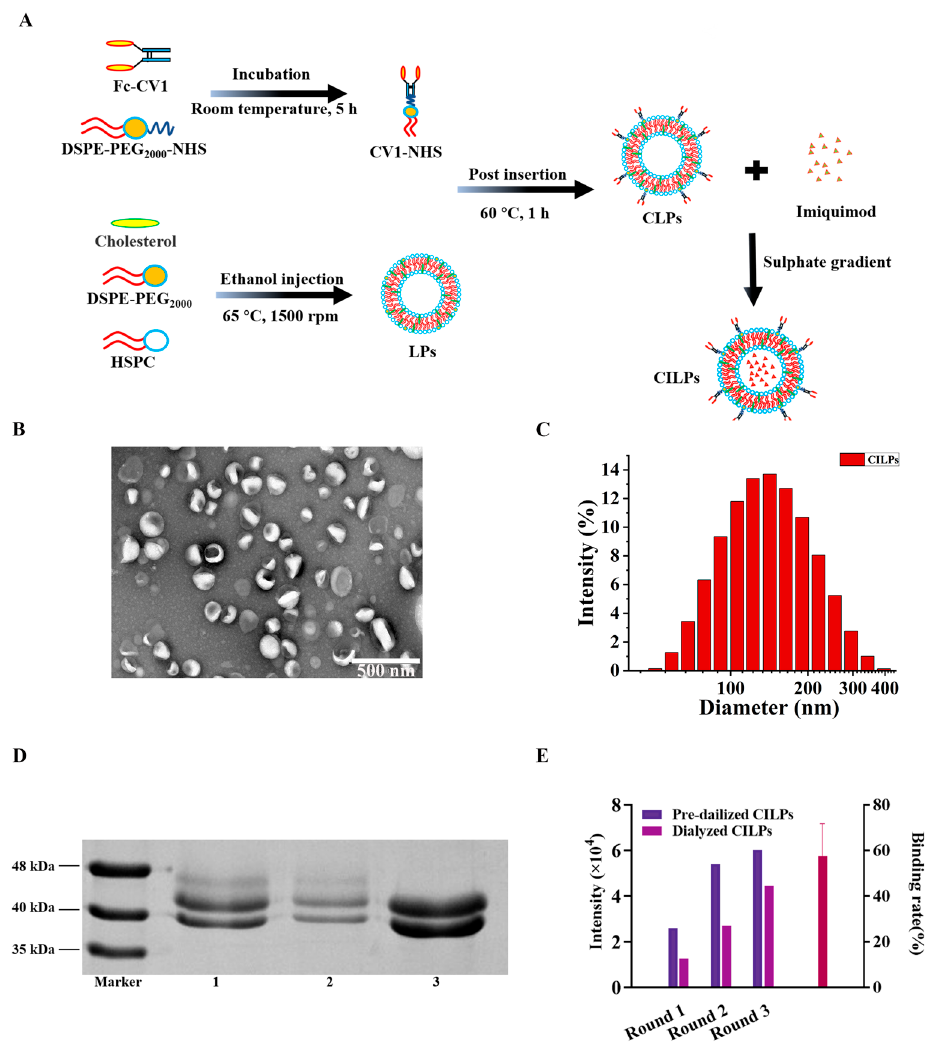
Figure 1. ( A ) Schematic illustration of the synthesis of CILPs. ( B ) TEM image of CILPs. ( C ) DLS curves of LPs, CLPs, ILPs, and CILPs. ( D ) SDS-PAGE determination of the molecular weight of Fc-CV1 (Lane 3) and the relative band brightness of Fc-CV1 in pre-dialyzed CILPs (Lane 1) and dialyzed CILPs (Lane 2) are shown. After being placed in a dialysis bag (300 kDa) and dialyzed against HEPES, only the Fc-CV1, which successfully bound ILPs (~100 nm), could be shown. This step was performed for three rounds in the same way. ( E ) The binding rate of Fc-CV1 inserted on LPs ( n = 3).